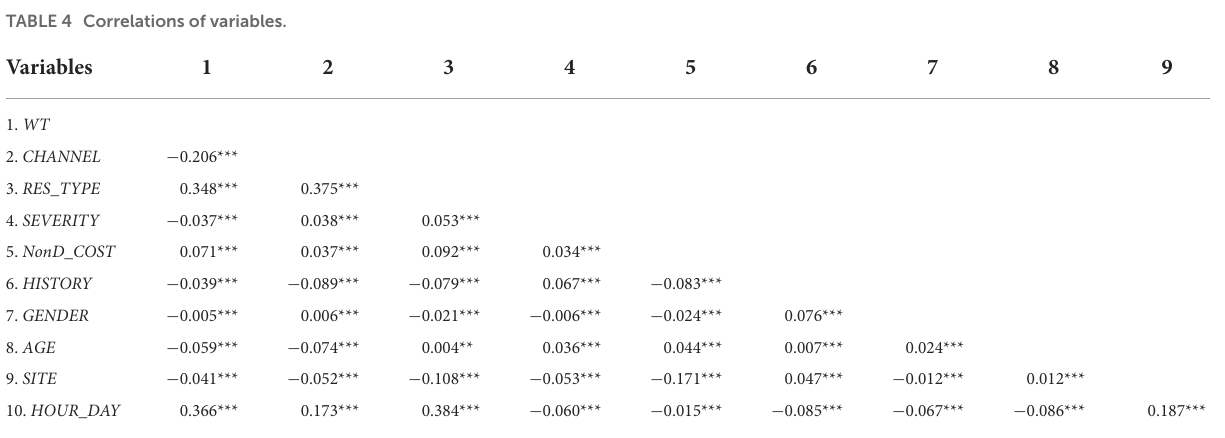
TABLE 4 Correlations of variables.